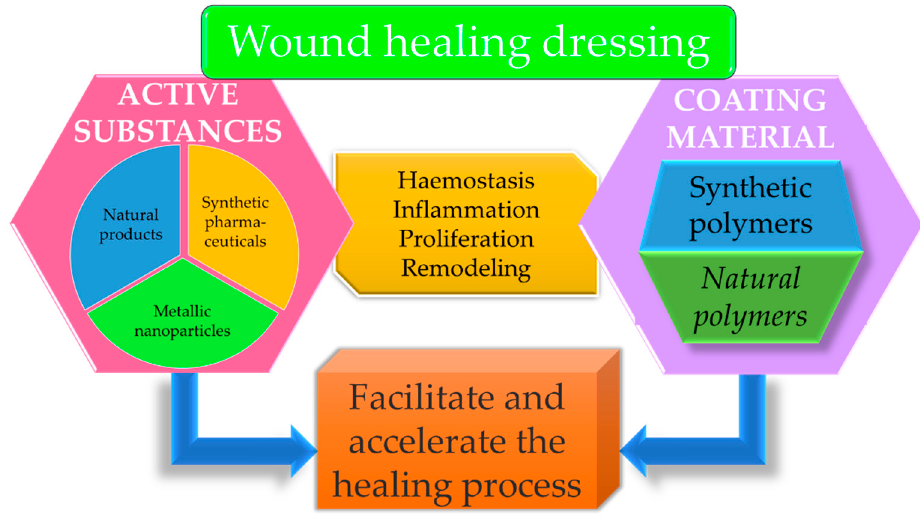
Figure 2. Schematic representation of a wound management process.